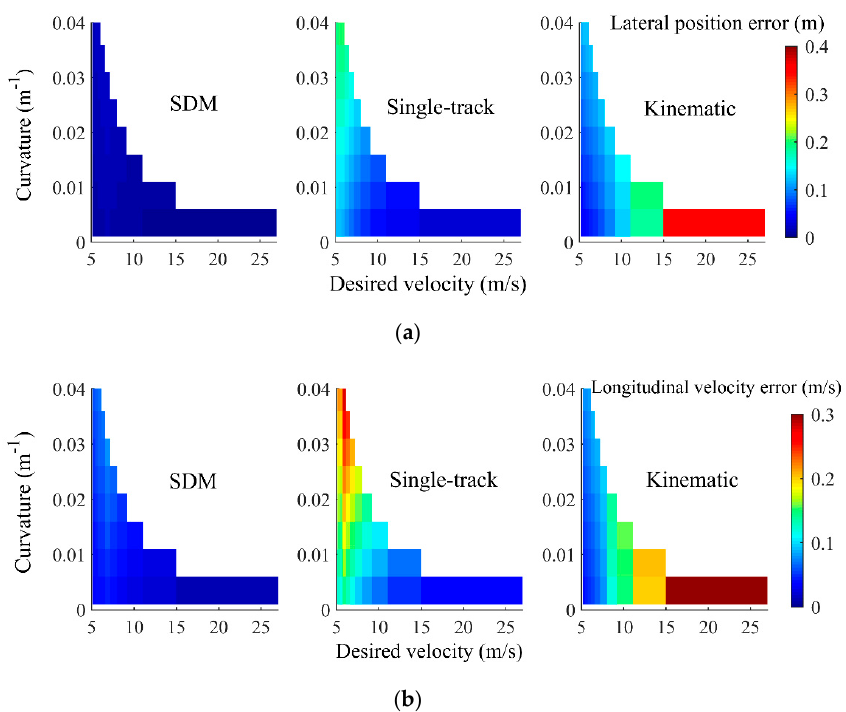
Figure 13. The statistical results: ( a ) lateral error position error; ( b ) longitudinal speed error.